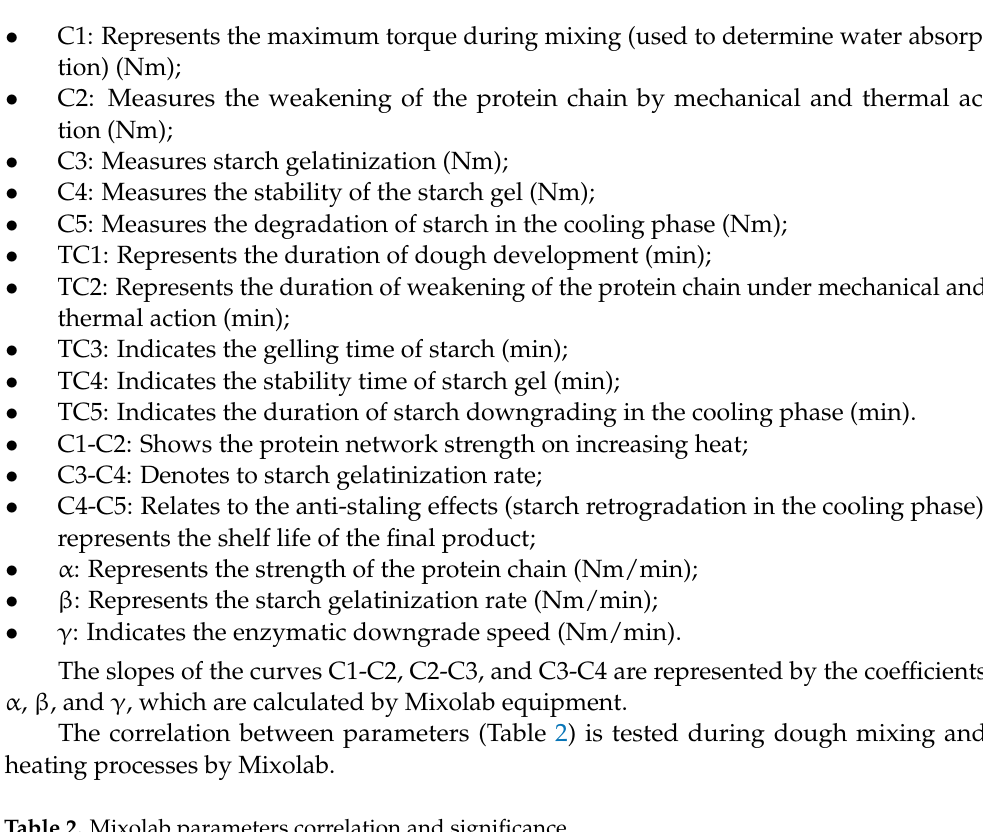
Table 2. Mixolab parameters correlation and